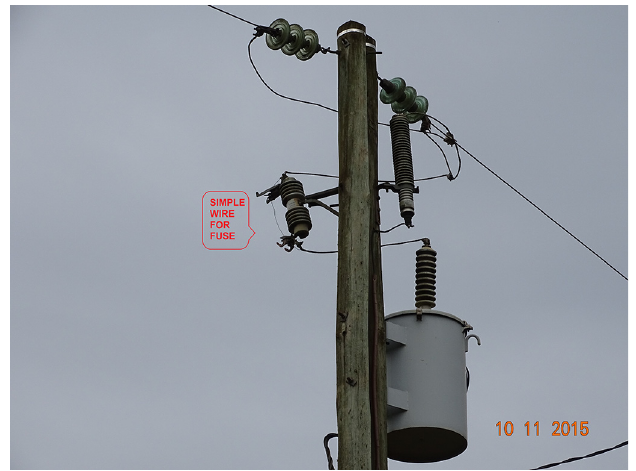
Fig. 15. A 17300 volts single wire ground return system with poor fuse system in Lingang (cid:1) Cameroon (PhotoJ. Kenfack).